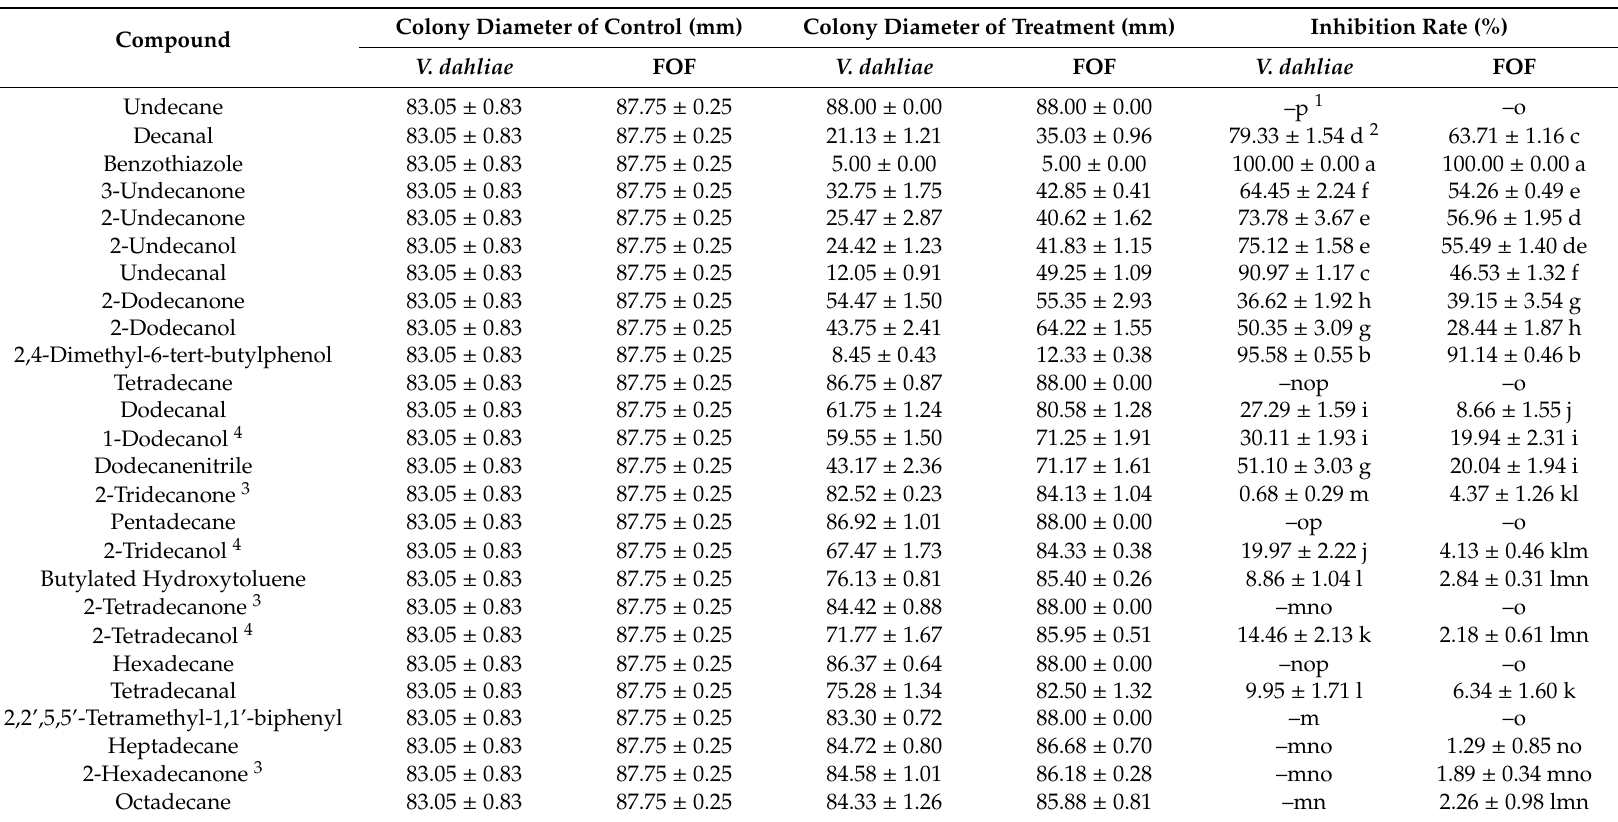
Table 2. Inhibitory e ff ect of 26 synthetic VOCs on the mycelial growth of V. dahliae and